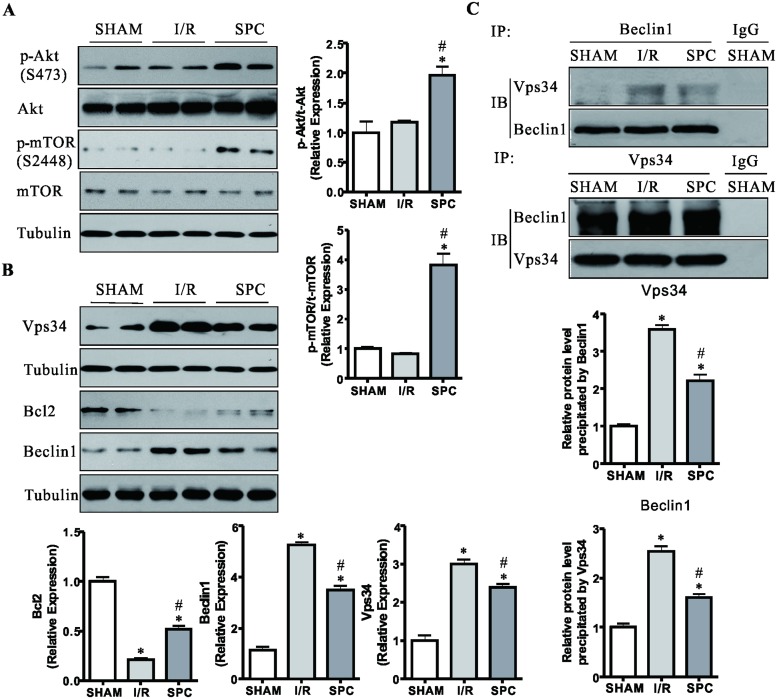
SPC plays an important regulatory role in the expression of class I/III PI3K and the interaction among Bcl2, Beclin1 and Vps34.
(A) LV tissues were collected from rats at the end of 2h reperfusion. The immunoblotting for phosphor-Akt (Ser473), Akt, phosphor- mTOR (Ser2448) and mTOR were performed. n = 4 /group. (B) Immunoblotting was used to examine the expression levels of Vps34, Bcl2 and Beclin1. Representative protein images and quantitative analysis were shown. The blots for Tubulin were served as loading controls. n = 4 /group. (C) Effect of SPC on I/R-induced association between beclin1 and Vps34. Upper panel, Cell lysates from LV tissues were immunoprecipitated (IP) with Beclin1 antibody and immunoblotted (IB) for Vps34 and Beclin1; Lower panel, Lysates were immunoprecipitated with Vps34 antibody and immunoblotted for Vps34 and Beclin1. The columns and errors bars represent means ± SD. * P < 0.05 vs. SHAM group; # P < 0.05 vs. I/R group.